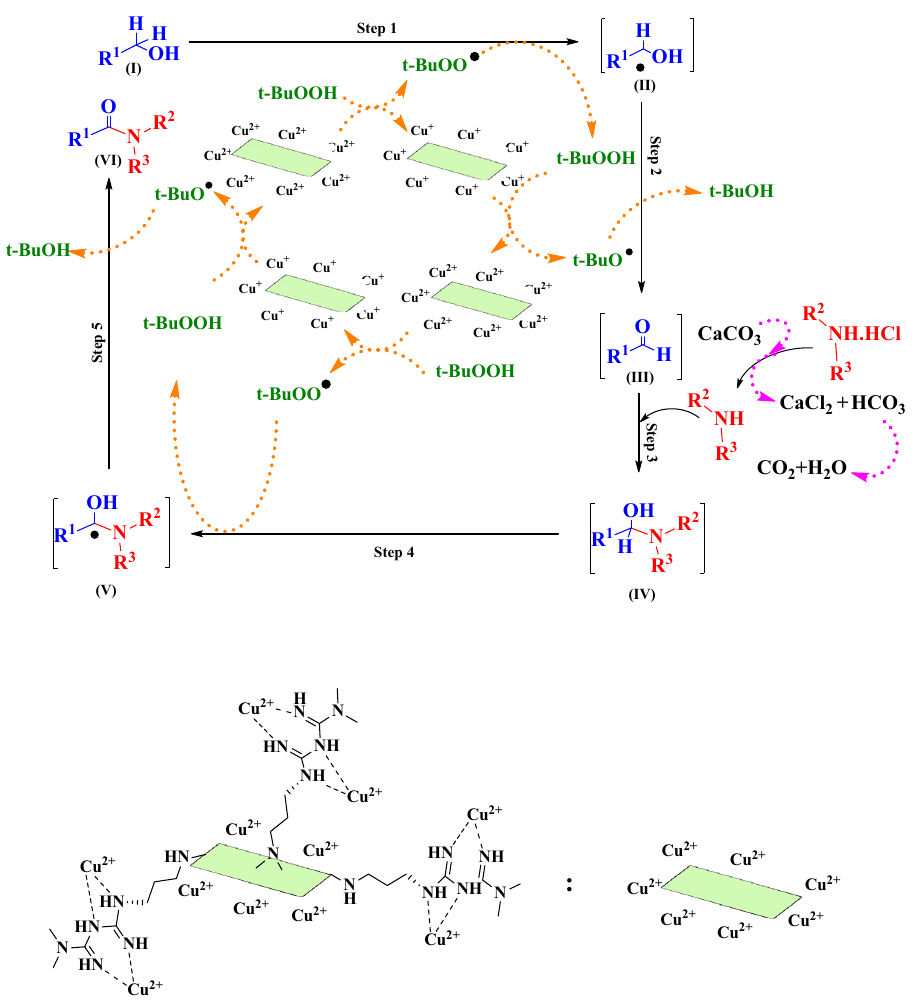
Figure 6. Proposed mechanism for tandem oxidative amidation reaction performed using the novel CN–Pr– Met–Cu(II) catalyst.